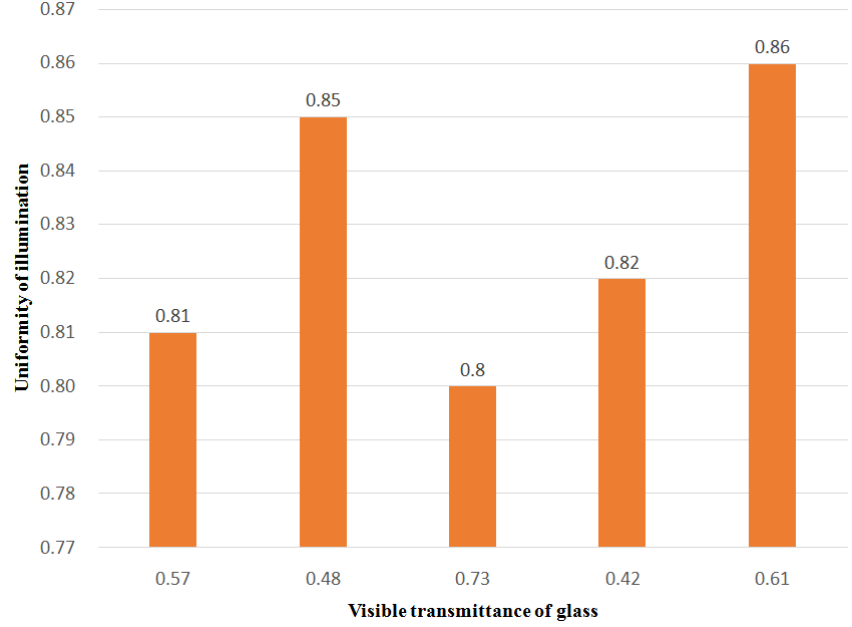
Fig. 6 Uniformity of illumination of the building.